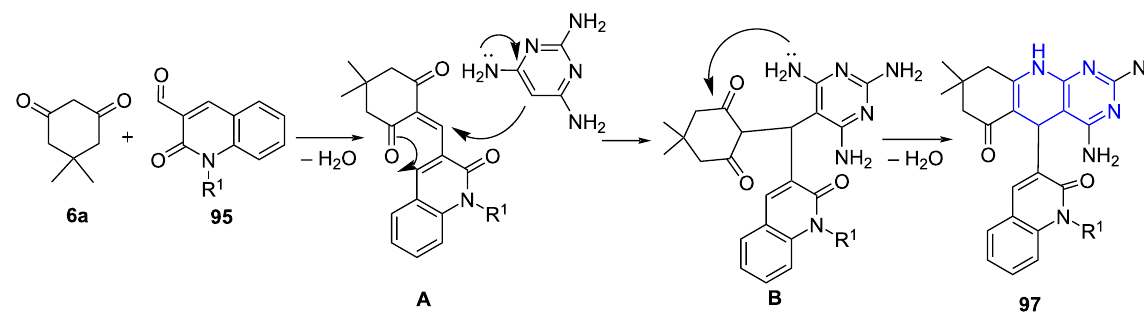
Scheme 37: Proposed mechanism for the formation of dihydropyridopyrimidine.